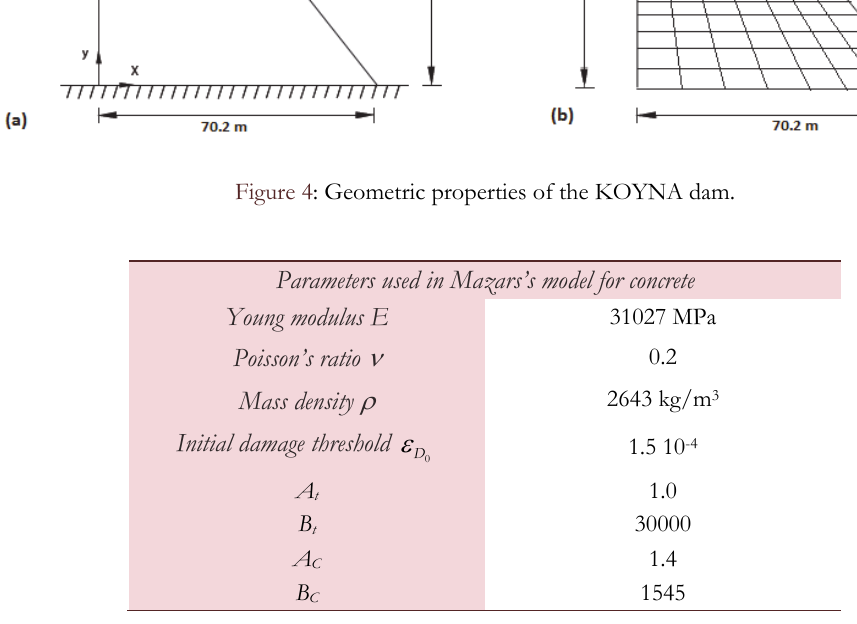
Table1: Material